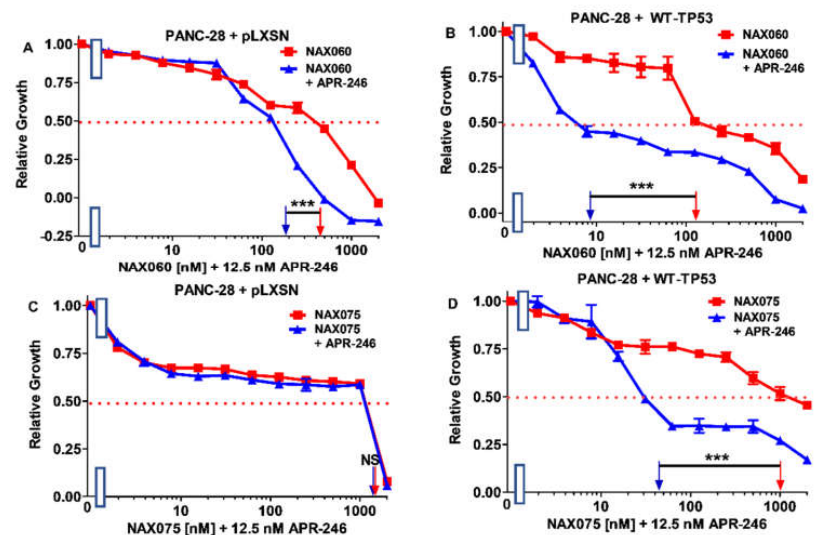
Figure 15. APR-246 enhances the effects of NAX060 on PANC-28 cells more in the presence of WT-TP53 than in the absence of WT-TP53, while APR-246 enhances the effects of NAX075 in the presence of WT-TP53 but not in the absence of WT-TP53. Panel ( A ) PANC-28 + pLXSN cells treated with different concentrations of NAX060 (red squares) or with different concentrations of NAX060 and a low dose of APR-246 (blue triangles). Panel ( B ) PANC-28 + WT-TP53 cells treated with different concentrations of NAX060 (red squares) or with different concentrations of NAX060 and a low dose of APR-246 (blue triangles). Panel ( C ) PANC-28 + pLXSN cells treated with different concentration of NAX075 (red squares) or with different concentrations of NAX075 and a low dose of APR-246 (blue triangles). Panel ( D ) PANC-28 + WT-TP53 cells treated with different concentrations of NAX075 (red squares) or with different concentrations of NAX075 and a low dose of APR-246 (blue triangles). The measurements were repeated, and similar results were observed. *** = p < 0.0001, NS, not statistically significant.